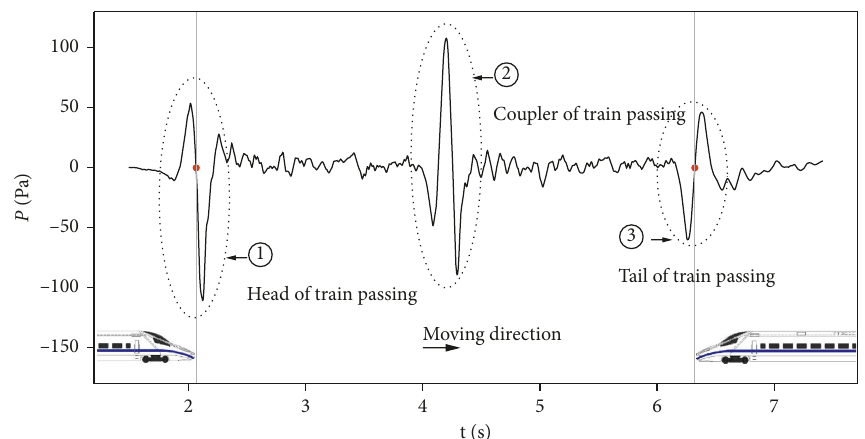
Figure 8: Air pressure signal produced by a high-speed train at a point under a platform canopy.